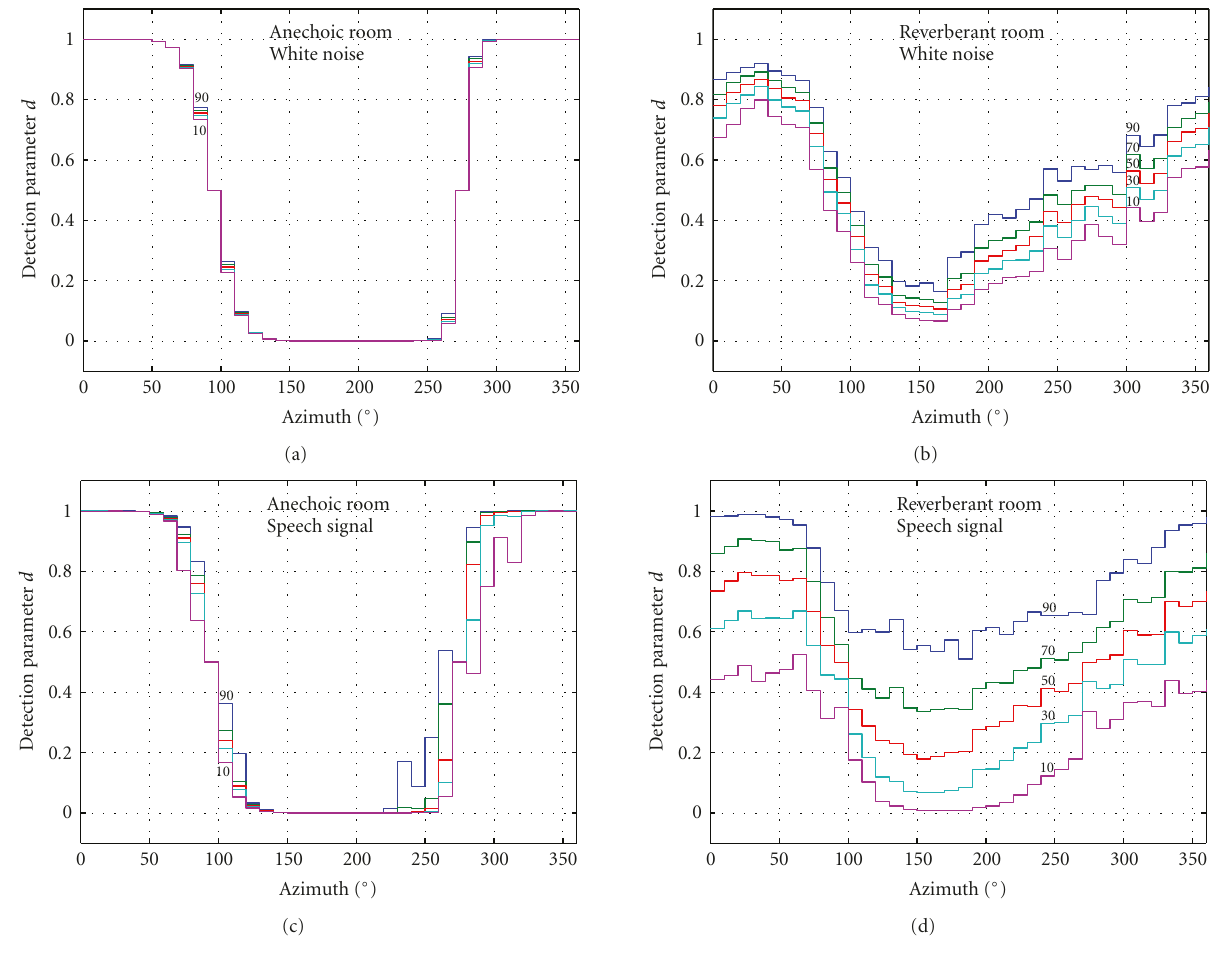
Figure 4: Performance of the delta-delta target signal detection algorithm in simulated anechoic and reverberant environments as a function of the direction of incidence of the signal using either white noise or a speech signal. Percentiles denote the percentage of time, during which the detection parameter d was lower than value